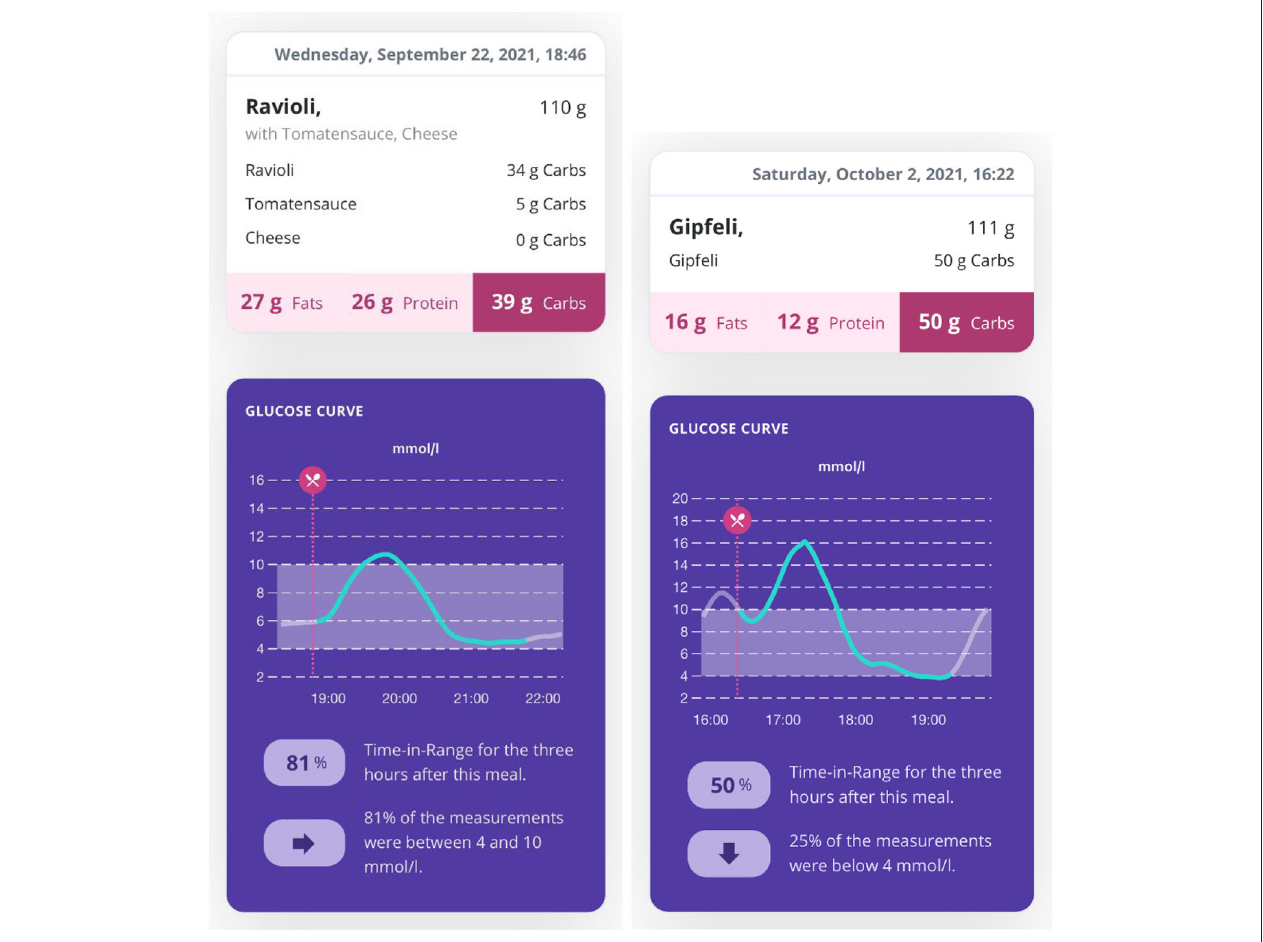
FIGURE 3 | Output of image-based automated food assessment and corresponding glucose profiles. The SNAQ app allows for automated analysis of meal macronutrients from photographed meals. Pairing with a continuous glucose monitor combines the meal information with the corresponding postprandial glucose